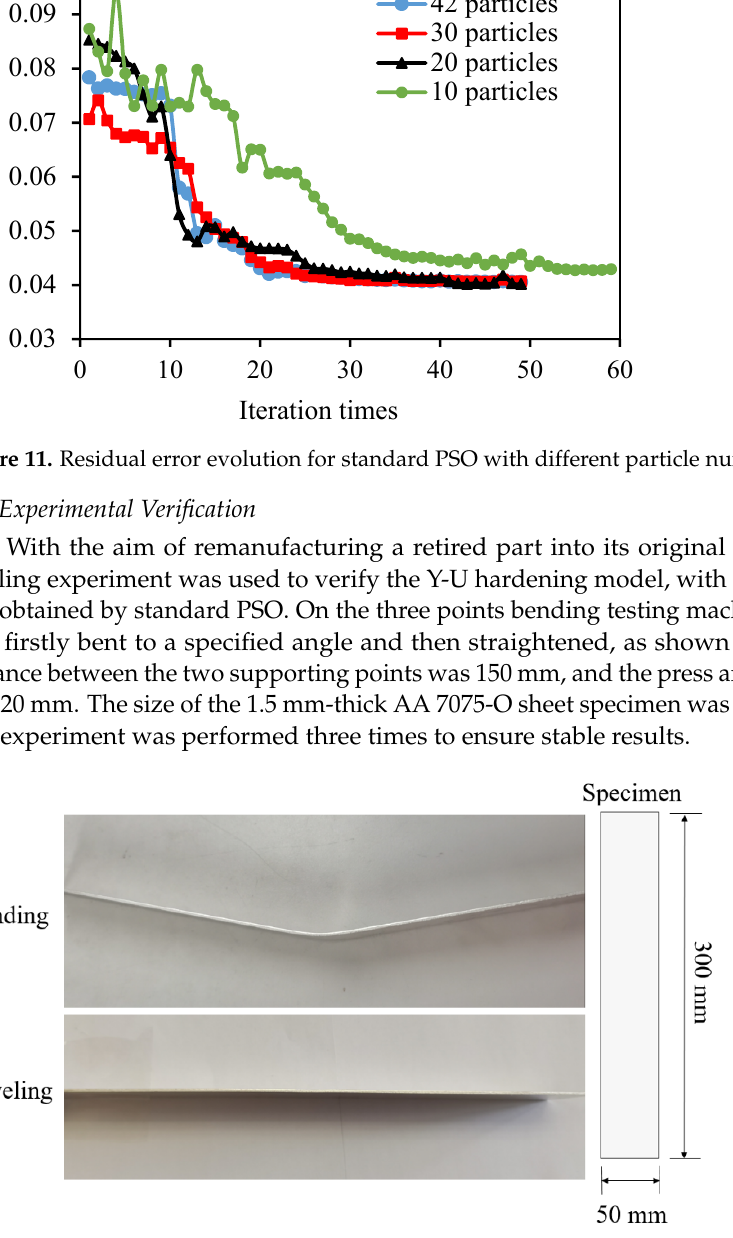
Figure 12. The bending-leveling experiment and specimen.